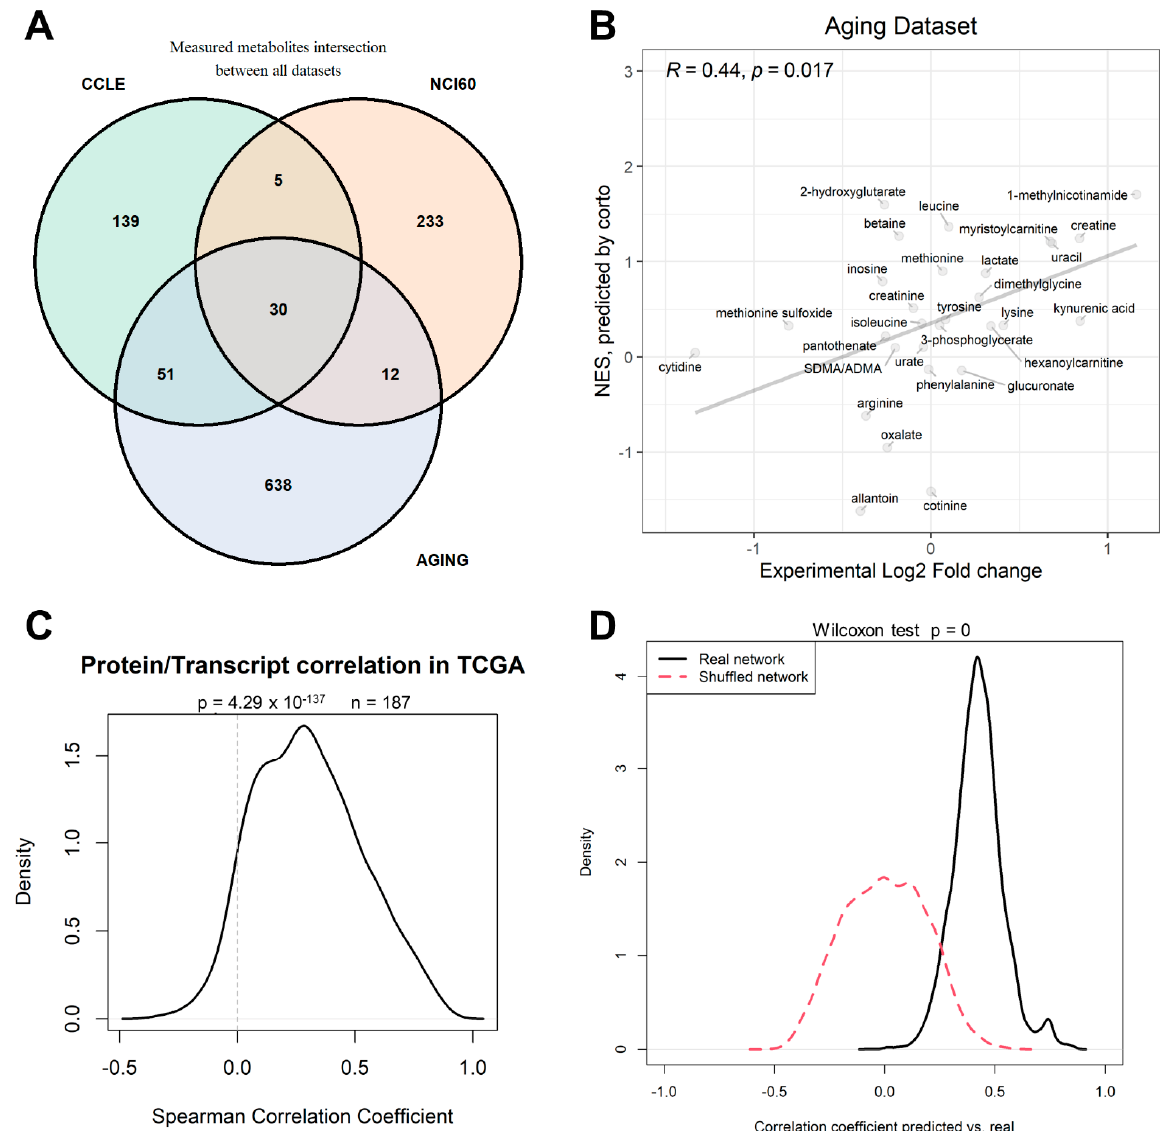
Figure 5. ( A ) Venn diagram depicting the number of metabolites measured in the three datasets analyzed in this paper: CCLE, NCI-60, and aging [44] datasets; ( B ) correlation in the monocyte pa- tient dataset from the aging dataset between calculated differential abundance ( x -axis) expressed as Log 2 Fold Change of old vs. young samples, and inferred differential abundance ( y -axis) expressed as corto -calculated NES (Normalized Enrichment Score) using the CCLE-based metabolite-transcript network (see Supplementary File S1) on gene expression profiles. ( C ) distribution of correlation coefficients between protein and transcript abundances from the same genes measured in TCGA datasets. ( D ) Distribution of correlation coefficients of predicted vs. measured metabolite levels in the CCLE dataset using 50%/50% testing/training split prediction across 1000 CCLE dataset splits; net- works used in the prediction were correctly inferred (black solid line) or shuffled (red dashed line).